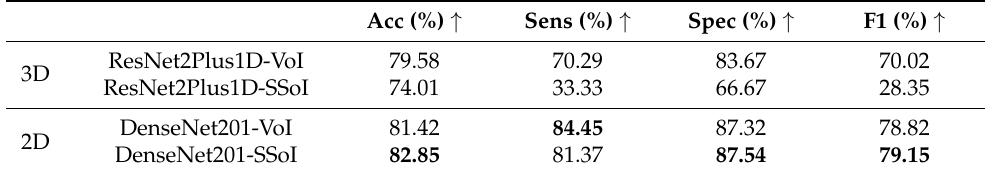
Table 3. Results on the COVID-19_CHDSET OS test set. Best results are highlighted in bold .